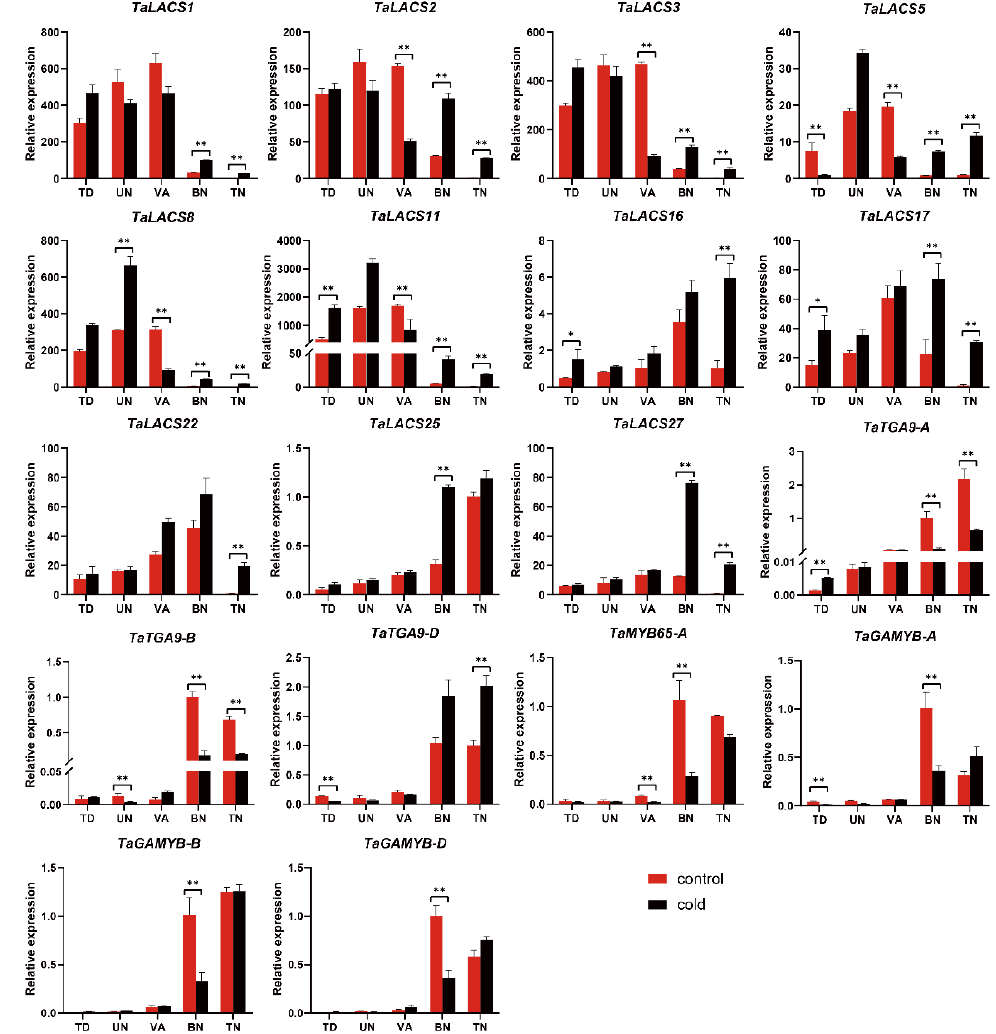
Figure 8. Expression of LACS genes and transcription factors in BS366 at different developmental stages between cold and control conditions. Asterisks indicate significant differences between cold and control conditions (Student’s t -test, * p -value < 0.05, ** p -value < 0.01). TD, tetrad stage; UN, uninucleate stage; VA, vacuolated stage; BN, binucleate stage; TN, trinucleate stage.